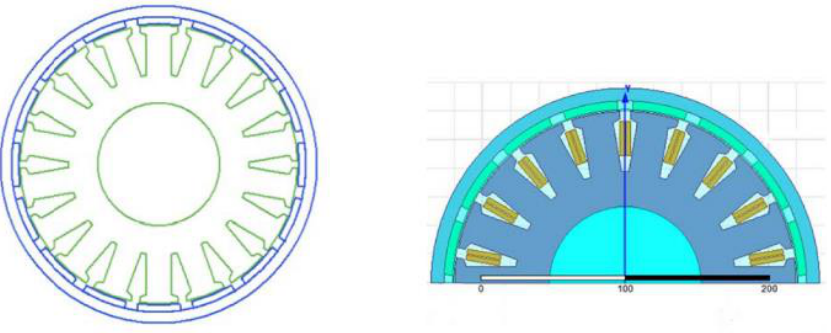
Figure 3. Prototype structure and finite element model.